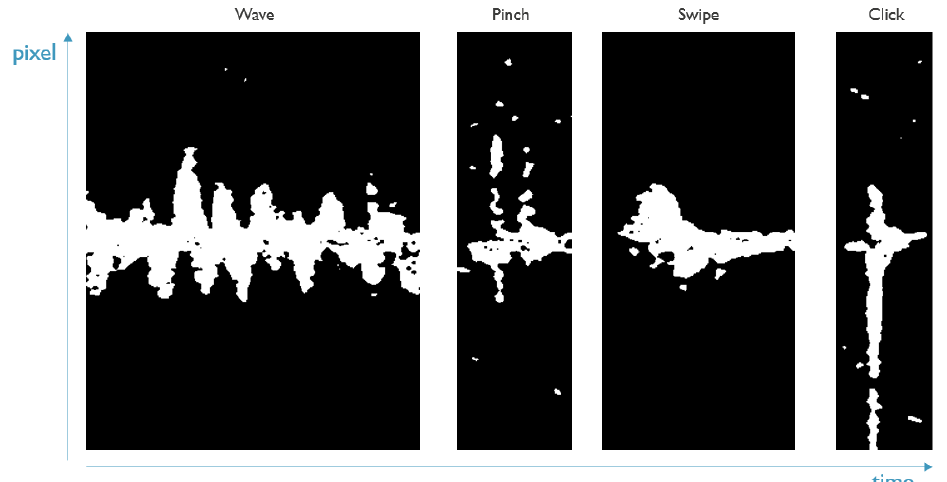
Figure 8. Wave, Pinch, Swipe, and Click binarized from the micro-Doppler spectrograms. Thus, the spectogram was converted to a grayscale image, followed by a Gaussian filter, and the minimum error